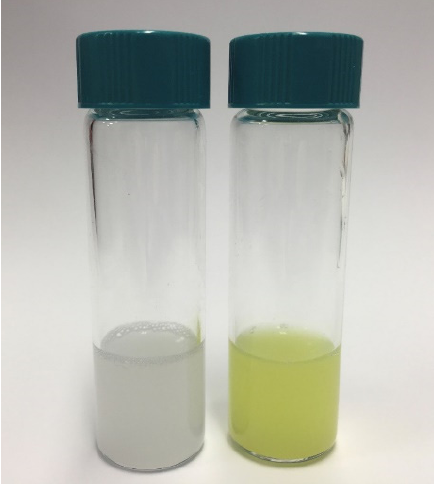
Figure 2. Liposomes loaded with curcumin (CurLIP) development. On the left photograph of liposomes before (left vial) and after (right vial) the addition of CUR. On the right table reporting dimensions (nm) and ζ -potential of liposomes in the absence and in the presence of CUR.